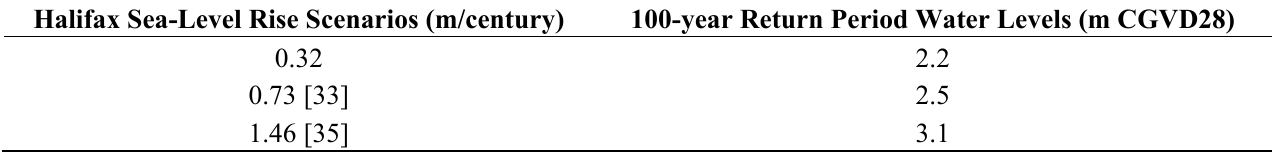
Table 3. 100-year return period water levels for Halifax based on different sea-level rise scenarios. Halifax Sea-Level Rise Scenarios (m/century)